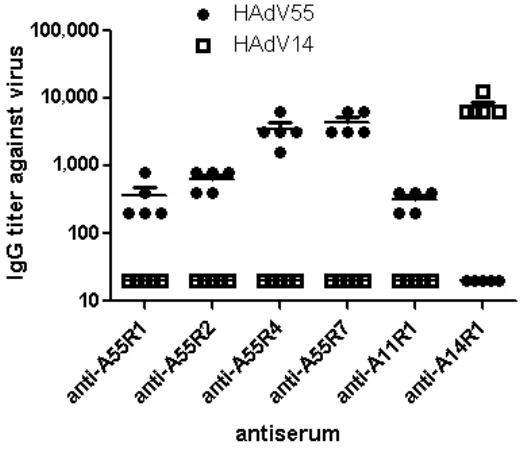
Figure 3. The type-specificity of anti-peptide sera by ELISA. Indirect ELISAs were performed to access the crossreactions of anti-peptide sera with purified HAdV55 and HAdV14 virions. Each experiment was repeated independently at least three times. Each symbol represented a mouse, and the means ± SEM for each group of mice are shown with the lines.